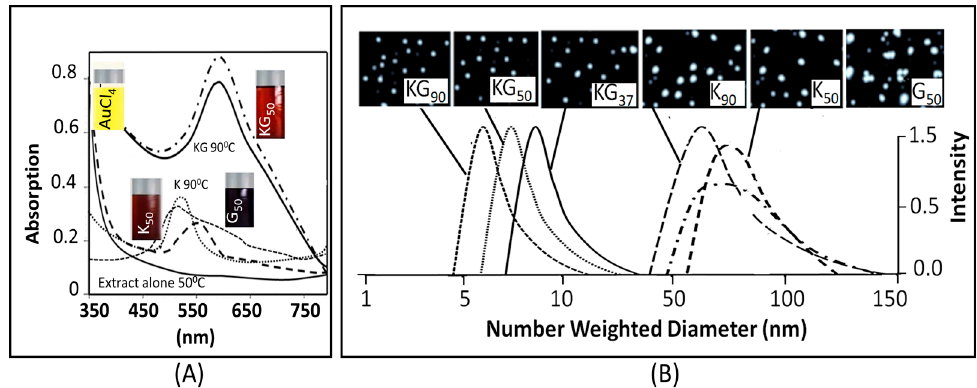
Figure 3. Optical absorption curves ( A ); size distribution and transmission electron microscopy ( B ) of different AuNP preparations. Abbreviations: K: kudzu, G: gum, and 37, 50, and 90: reaction temperature in °C.